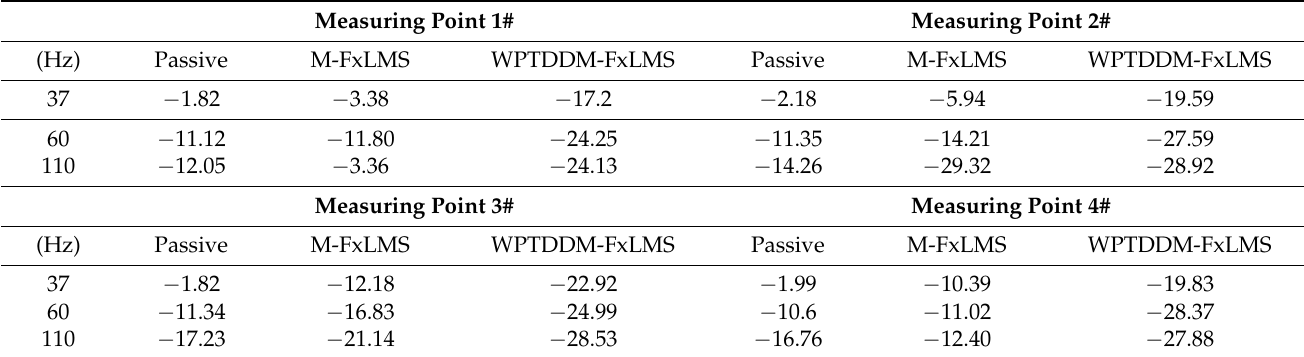
Figure 19. ( a ) The time domain acceleration signal in measuring point 4#; ( b ) the acceleration signal spectrum in measuring point 4#. Table 2. Test control effect for two algorithms.